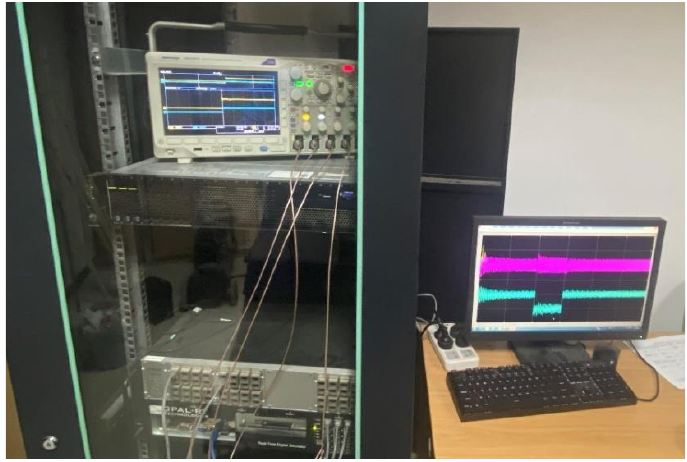
Figure 14. Simulation platform.